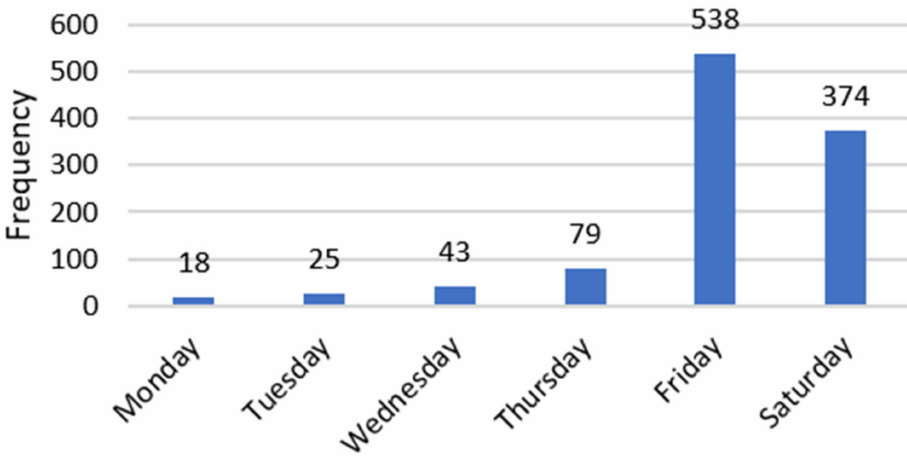
Figure 1. Preferred day of the week for taking part in an online professional